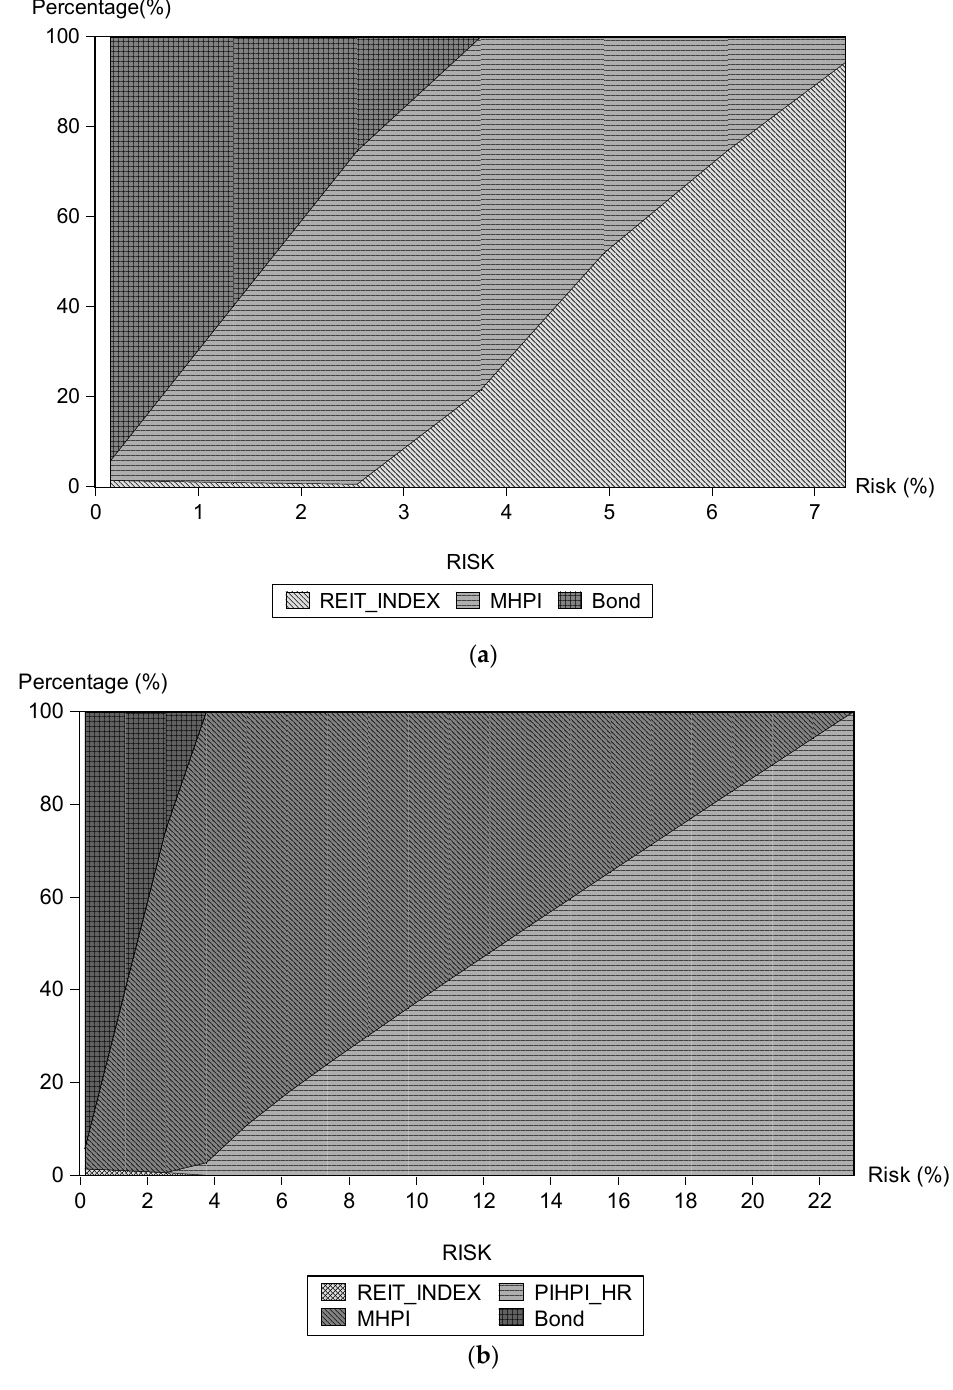
Figure 2. ( a ): Asset Allocation of Portfolio_CV (2009–2019). ( b ): Asset Allocation of Portfolio_HR (2009–2019).